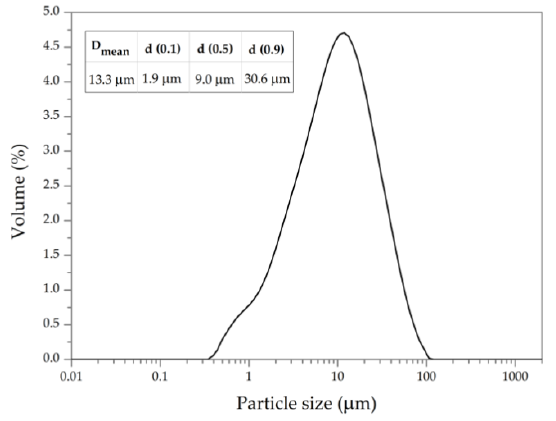
Figure 3. Particle size distribution of RSA.